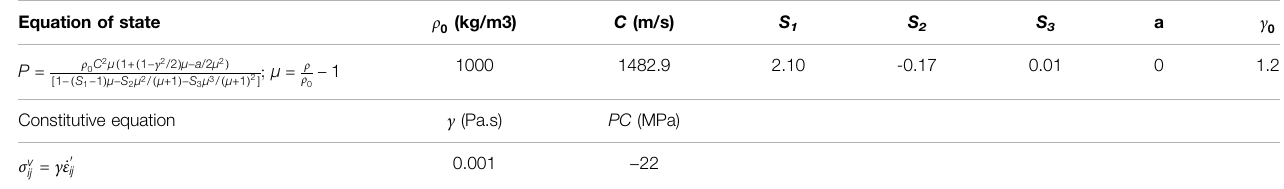
TABLE 1 | Material constant for the cerebral ventricles in the TH-Model and NTH-Model. P : pressure, C : intercept of v s − v p curves, v s : velocity of a shockwave traveling through the intermediary material, v p : velocity ofthe shocked material; S1, S2, and S3: coef fi cients ofthe slope ofthe v s − v p curves, γ 0 : Gruneisengamma, a : fi rst order volume correction to γ 0 ; ρ 0 : initial density; ρ : instantaneous density; σ v ij : deviatoric stress; γ : dynamic viscosity; _ ε ij ′ : deviatoric strain rate; PC : cut-off pressure. Equation of state ρ 0